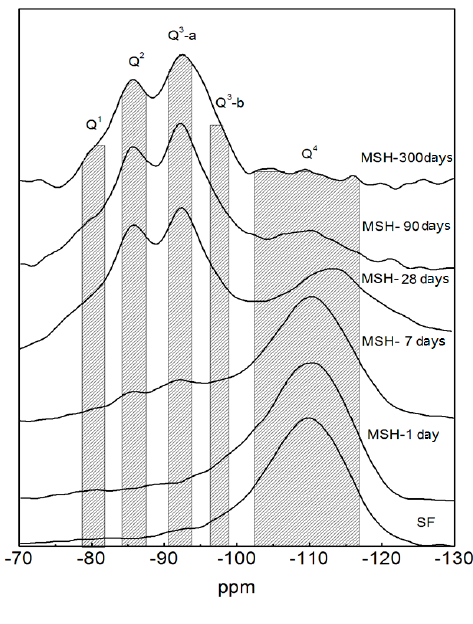
Figure 4. 29 Si MAS NMR spectra of the MSH samples for different curing time. Materials 2018 , 11 , x FOR PEER REVIEW